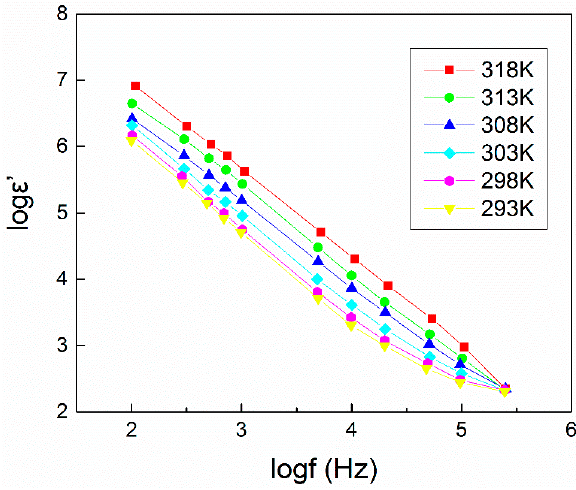
Figure 13. Variation of dielectric constant with frequency at different temperatures for PEO (8 × 10 6 g/mol)–LiClO 4 (EO:Li + = 11)–LiAlO 2 ( d = 41 nm, n nanoparticle / n Li = 1.5) CPE. Data from Masoud et al. [144].